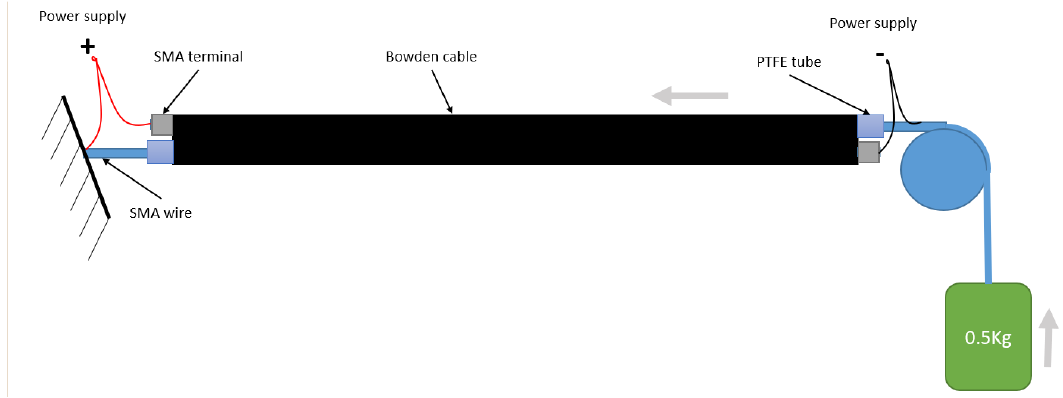
Figure 12. Double actuator